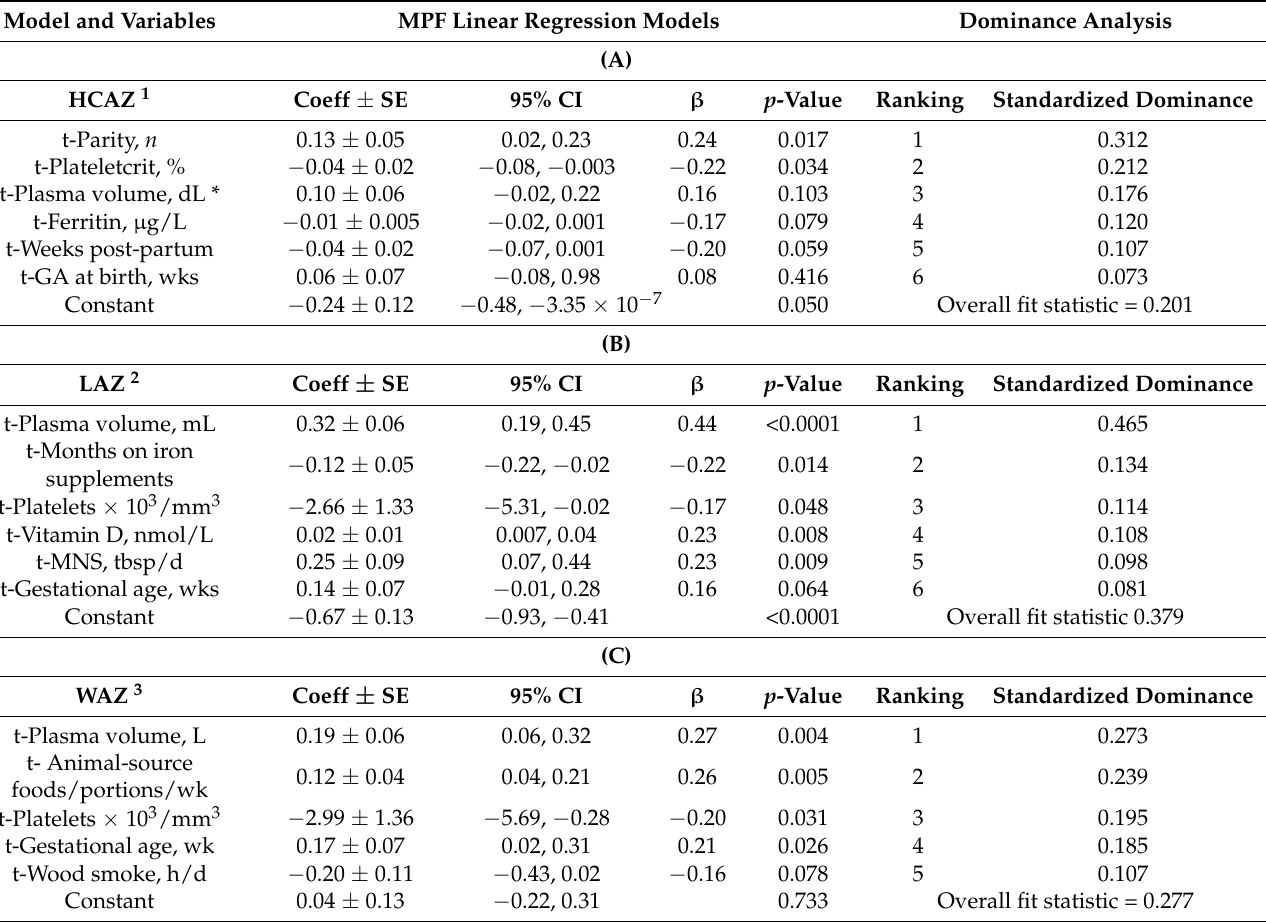
Table 6. MFP linear regression models for infant anthropometric